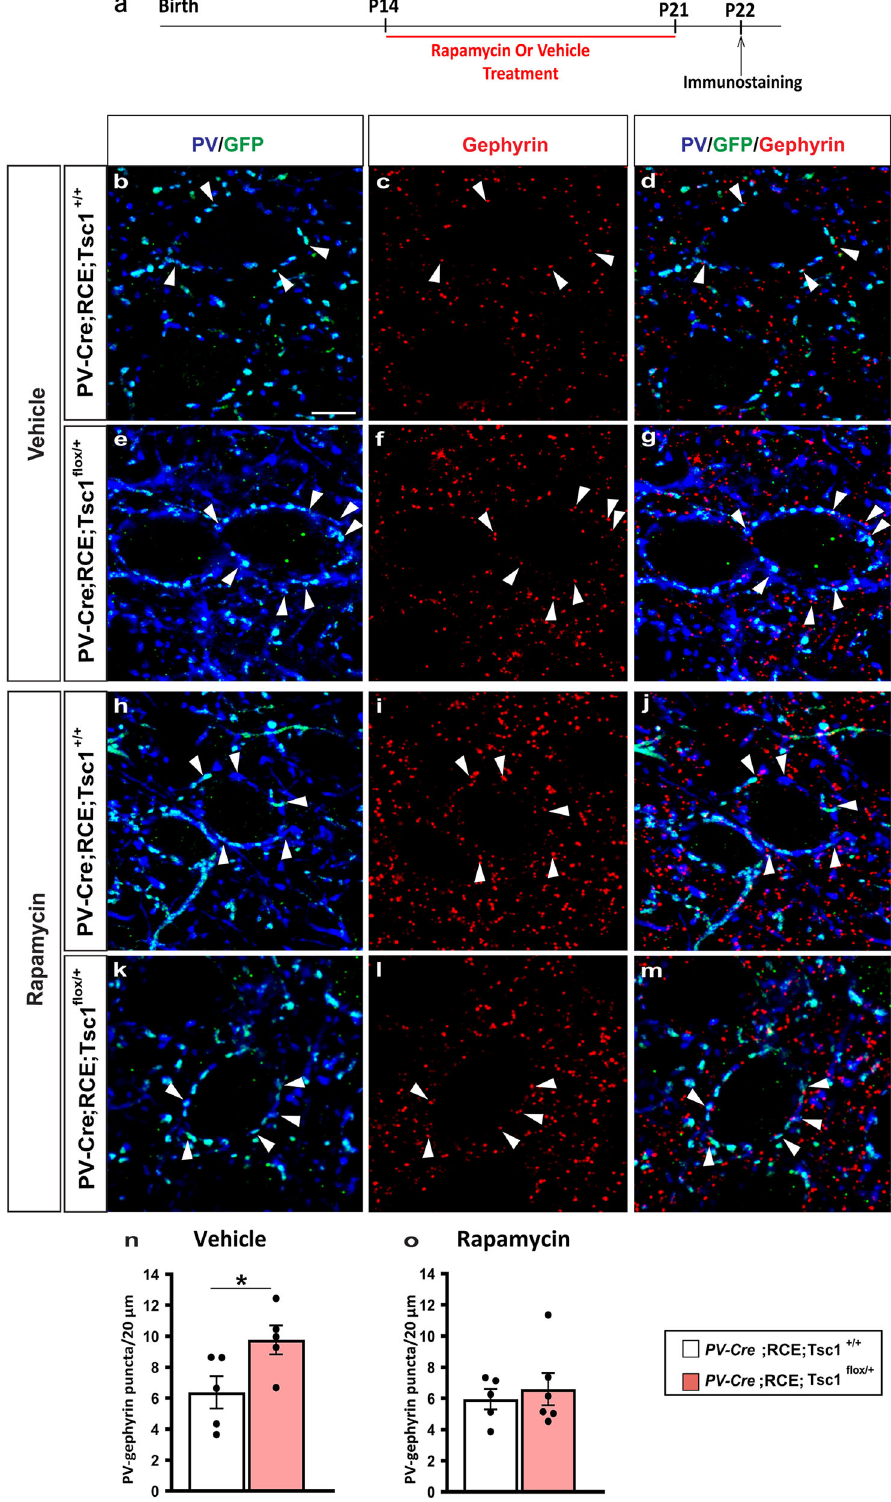
Fig. 9 Short term Rapamycin treatment rescues the premature increase of PV cell perisomatic innervation caused by Tsc1 haploinsuf fi ciency. a Schematic of the treatment paradigm. b – m Representative immunostained sections of somatosensory cortex labeled for PV/GFP (blue/green) and gephyrin (red) in Vehicle ( b – g ) and Rapamycin ( i – m ) treated P22 mice showing PV/GFP-Gephyrin colocalized boutons (arrowheads) ( d , g and j , m ). Scale bar: 5 μ m. n , o PV/GFP-Gephyrin colocalized puncta in Vehicle-treated ( n , Welch ’ s t -test, * p = 0.0423) and Rapamycin-treated mice ( o , Welch ’ s t -test, p = 0.6088). Vehicle treatment: n = 5 for both PV-Cre;RCE;Tsc1 + / + and PV-Cre;RCE;Tsc1 fl ox/ + mice. Rapamycin treatment: n = 5 PV-Cre;RCE;Tsc1 + / + , n = 6 PV-Cre;RCE;Tsc1 fl ox/ + mice. Data represent mean ± SEM. Source data are provided as a Source Data fi